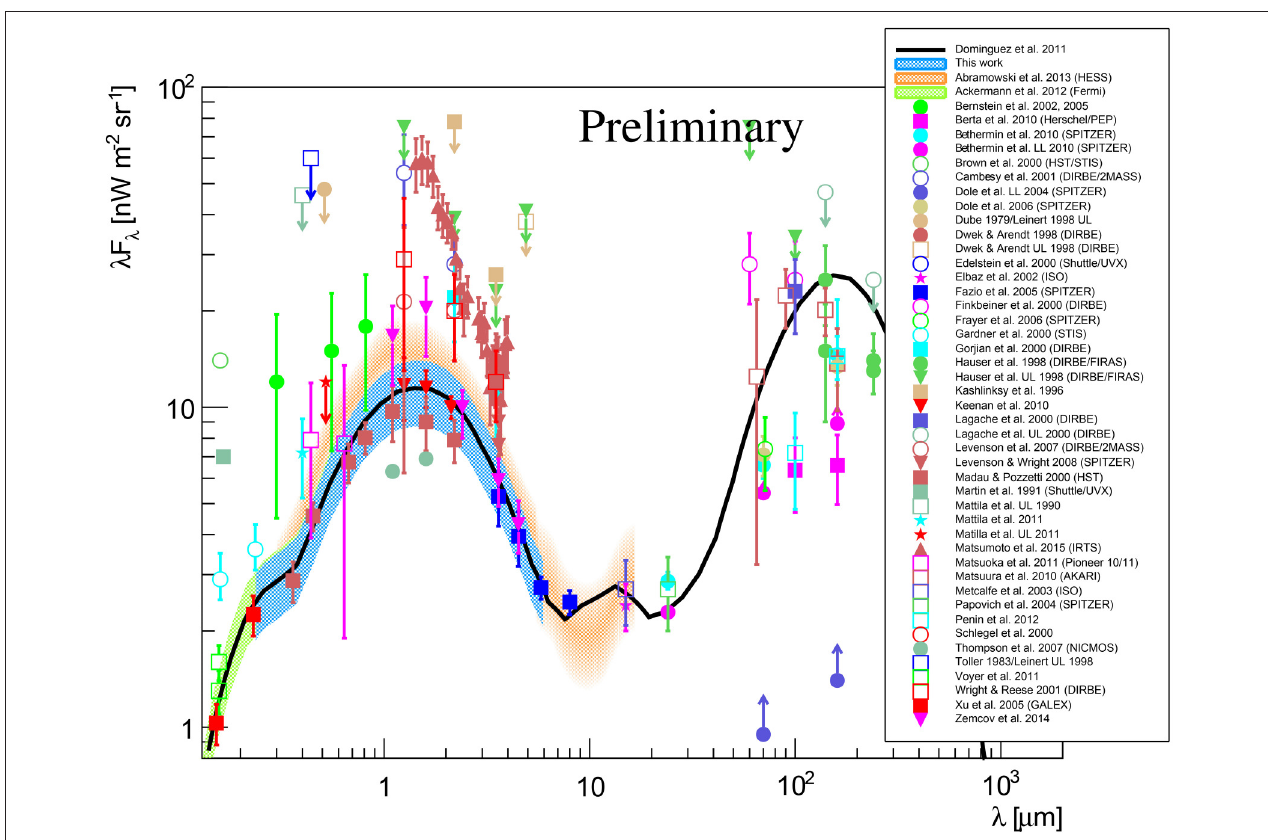
FIGURE 2 | A collection of EBL measurements with our measurements (blue area). The reported uncertainties are statistical